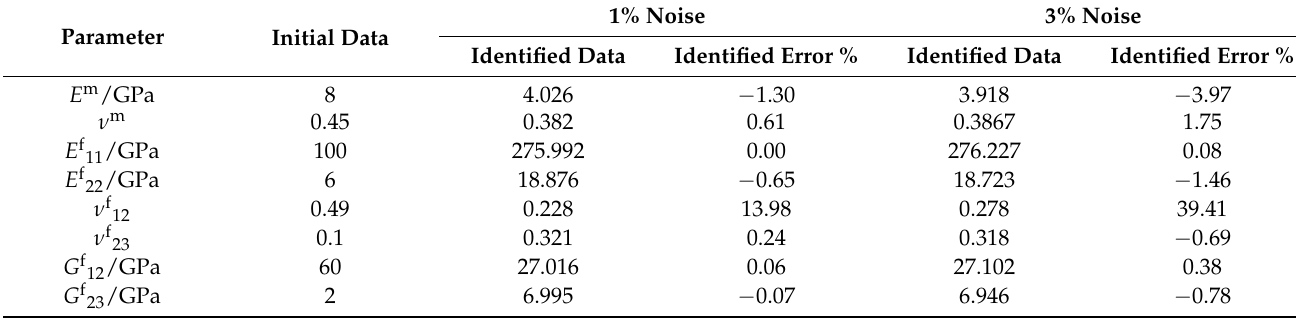
Table 9. Identified constituent parameters of composite